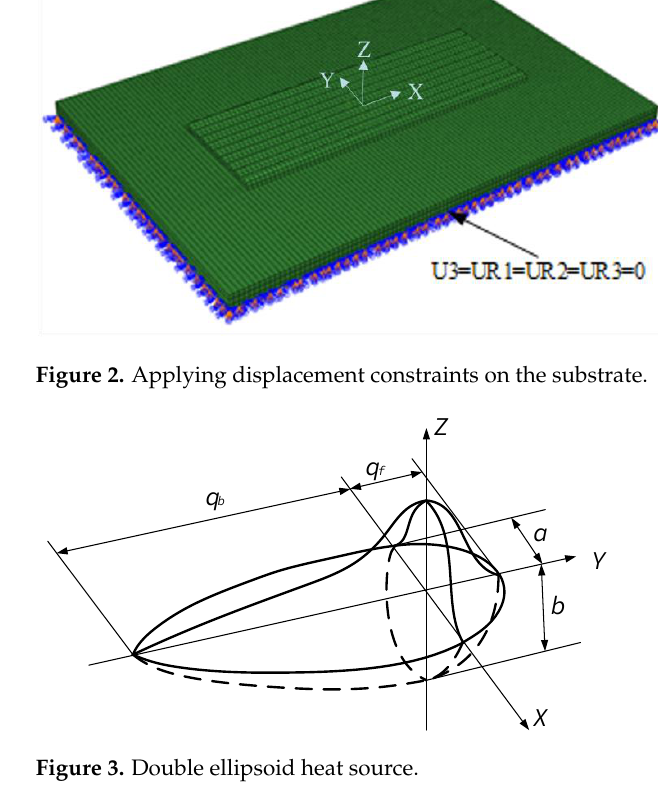
Figure 3. Double ellipsoid heat source.